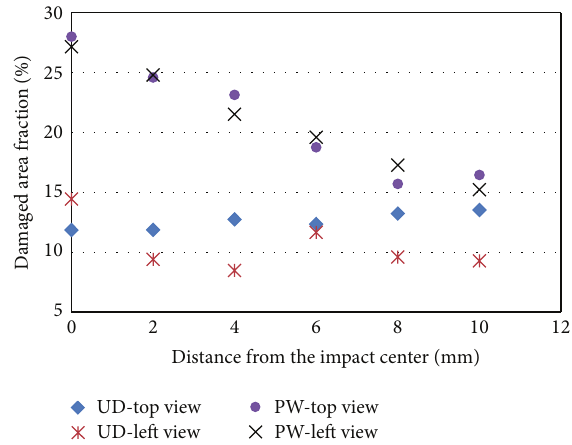
Figure 14: Area fraction of damaged zones in the impacted UD and PW samples, as function of distance from the impact